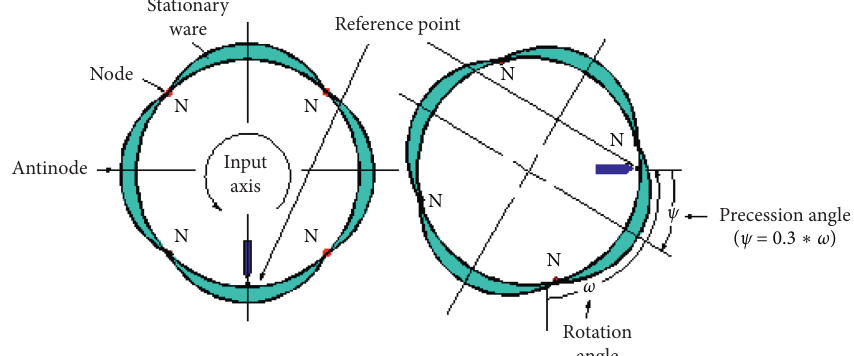
Figure 2: The angle hysteresis principle of the hemispherical